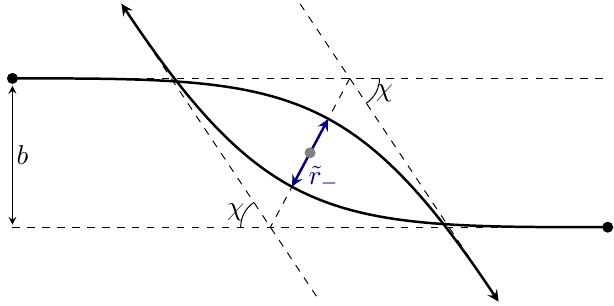
Figure 1. The geometry of the scattering problem in the center of mass frame (gray dot). The motion of the bodies traces two hyperbolas, which are separated by ˜ r − at the point of closest